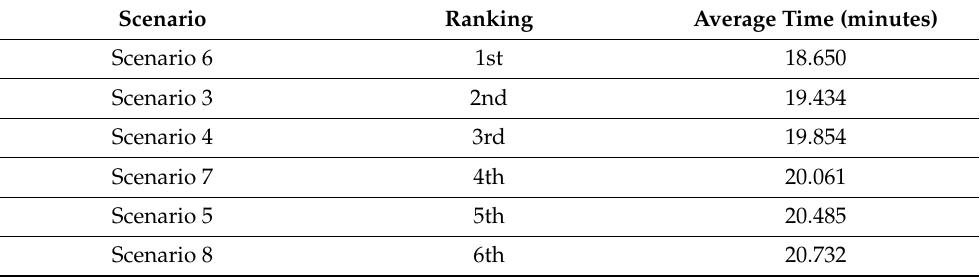
Table 9. Ranking of scenarios (3–8) based on average time from 12 simulations.